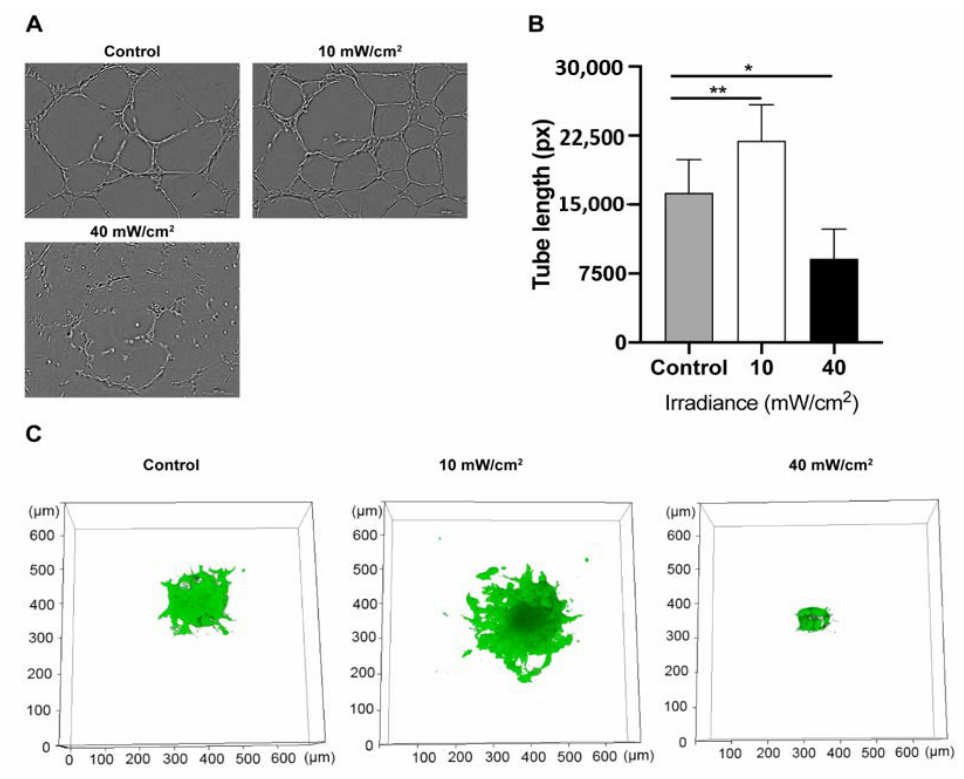
Figure 4. Blue light affected tube formation and sprouting in human umbilical vein endothelial cells (HUVECs): ( A ) Representative images of the tube formation assay of HUVECs following exposure to either low fluence (10 mW/cm 2 × 12 min) or high fluence (40 mW/cm 2 × 12 min) illumination at 6 h after irradiation. ( B ) Quantification of data from tube formation assays. Data are shown as mean ± SD ( n = 3 repetitions, * p < 0.05, ** p < 0.01, one-way ANOVA). ( C ) Representative images of the spheroid sprouting assay of HUVECs with GFP following exposure to either low fluence (10 mW/cm 2 × 12 min) or high fluence (40 mW/cm 2 × 12 min) at 6 h after